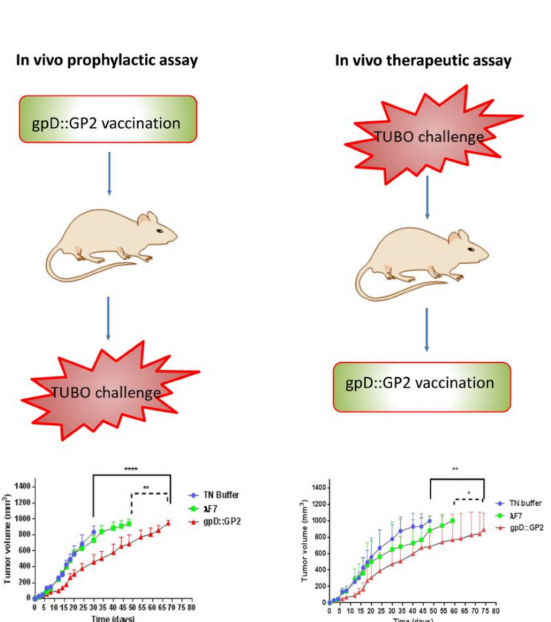
Figure 4. A schematic summary of the breast cancer vaccine study (gpD::GP2) in a TUBO tumor model of BALB/c mice. Adapted with permission from NPG. * p <0.05, ** p <0.01 and **** p <0.0001; denotes significant difference from the control